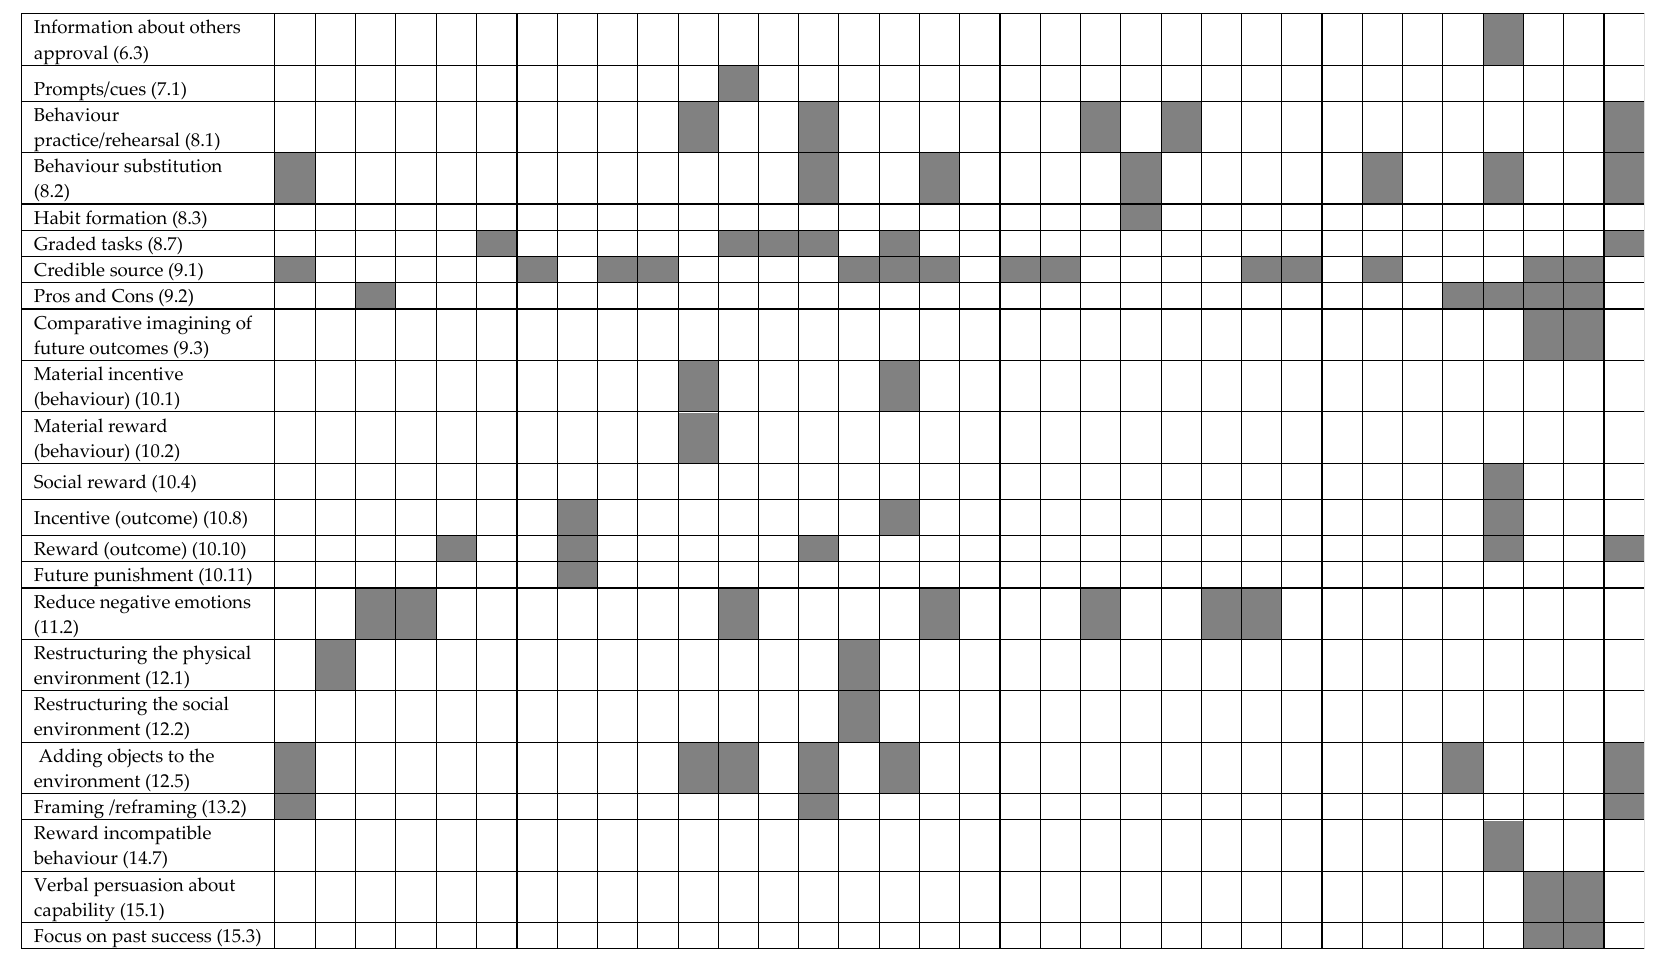
Figure 1. Identified behaviour change strategies in lifestyle interventions from the included studies ( n =